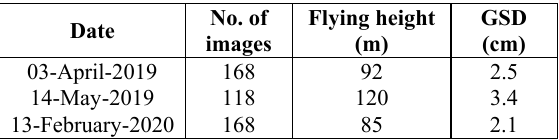
Table 1. Properties of datasets and flights.